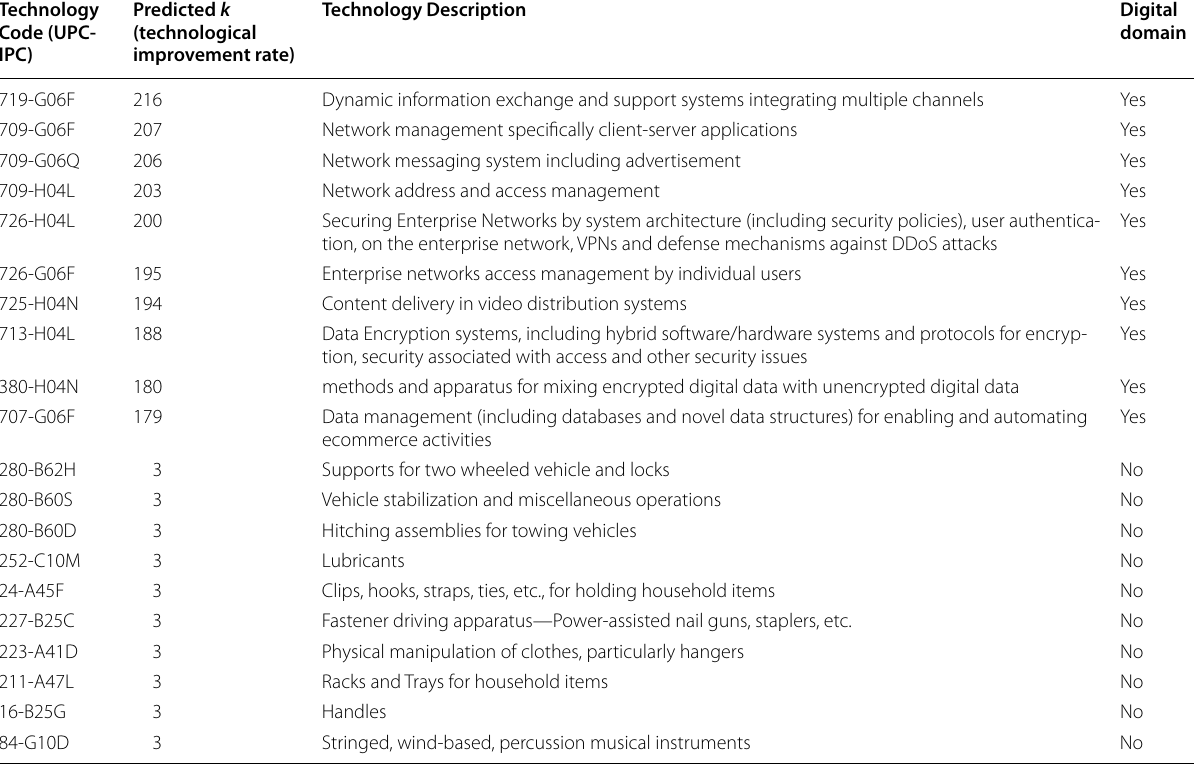
Table 3 Improvement rates of the 10 top and bottom ranked